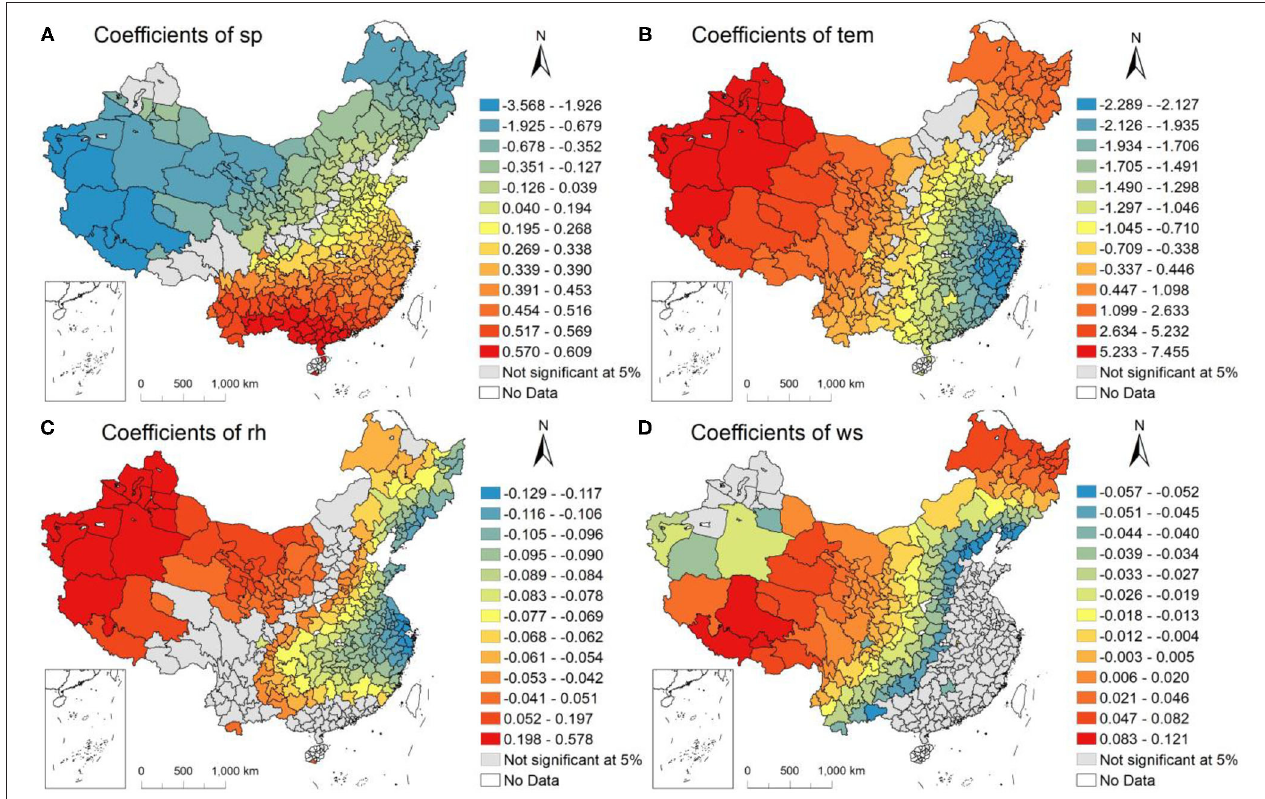
FIGURE 5 | Results of natural factors from the GTWR in 332 Chinese cities. (A) Coefficients of surface pressure (sp), (B) coefficients of temperature (tem), (C) coefficients of relative humidity (rh), and (D) coefficients of wind speed